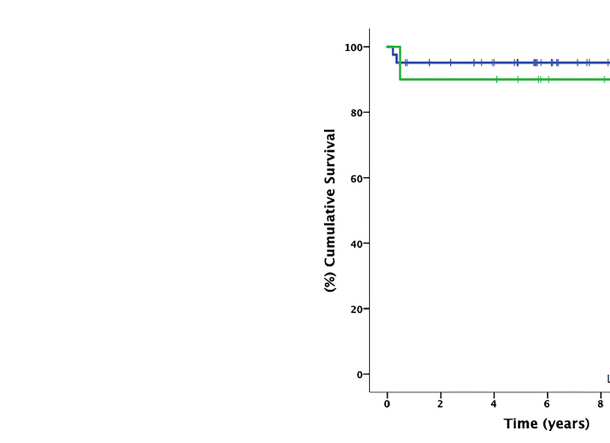
FIGURE 2 Overall Survival strati fi ed by KRAS copy number in